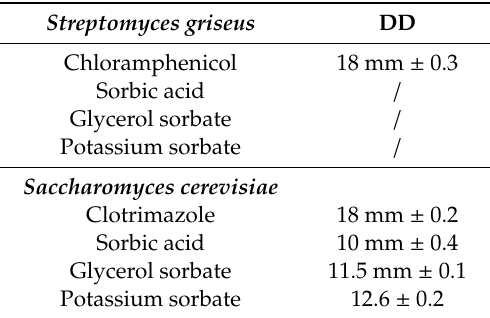
Table 2. Antimicrobial activity of sorbic acid, glycerol and the two positive controls chloramphenicol and